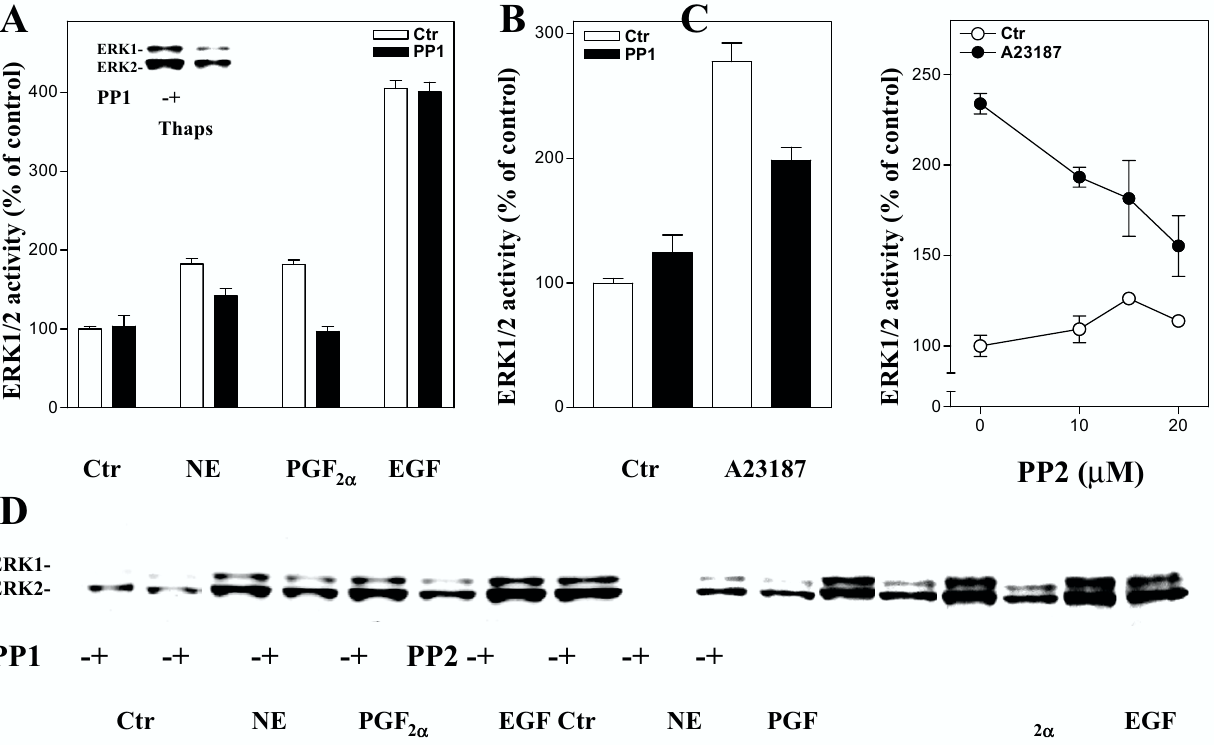
Figure 7 Effect of inhibition of Src kinases on ERK1/2 activation. A-D: Hepatocytes were cultured for 3 h prior to preincubation for 30 min with timolol (10 µ M) and the Src kinase inhibitors PP1 or PP2 at indicated concentrations in 0.5 % DMSO before stimula- tion for 5 min with norepinephrine (10 µ M), PGF 2 α (10 µ M), EGF (10 nM), thapsigargin (1 µ M), or A23187 (10 µ M). A: ERK1/ 2 activity, given as percent of untreated control, induced by hormonal agents expressed as the mean ± S.E.M. of four experi- ments after treatment with PP1 (10 µ M). The inset shows an immunoblot of the effect of PP1 (20 µ M) on thapsigargin-induced ERK1/2 response. B: A23187-induced ERK1/2 response after PP1 (10 µ M) treatment. Results represent mean ± S.E.M of three experiments. C: Dose-response curve for the effect of PP2 on ERK1/2 activity induced by A23187. Results represent mean ± S.E.M of three experiments. All activity measurements (A-C) are expressed as percent of untreated control. D: Immunoblots showing the effect of PP1 (10 µ M) or PP2 (10 µ M) on ERK1/2 responses. Antibody against dually phosphorylated ERK1/2 was